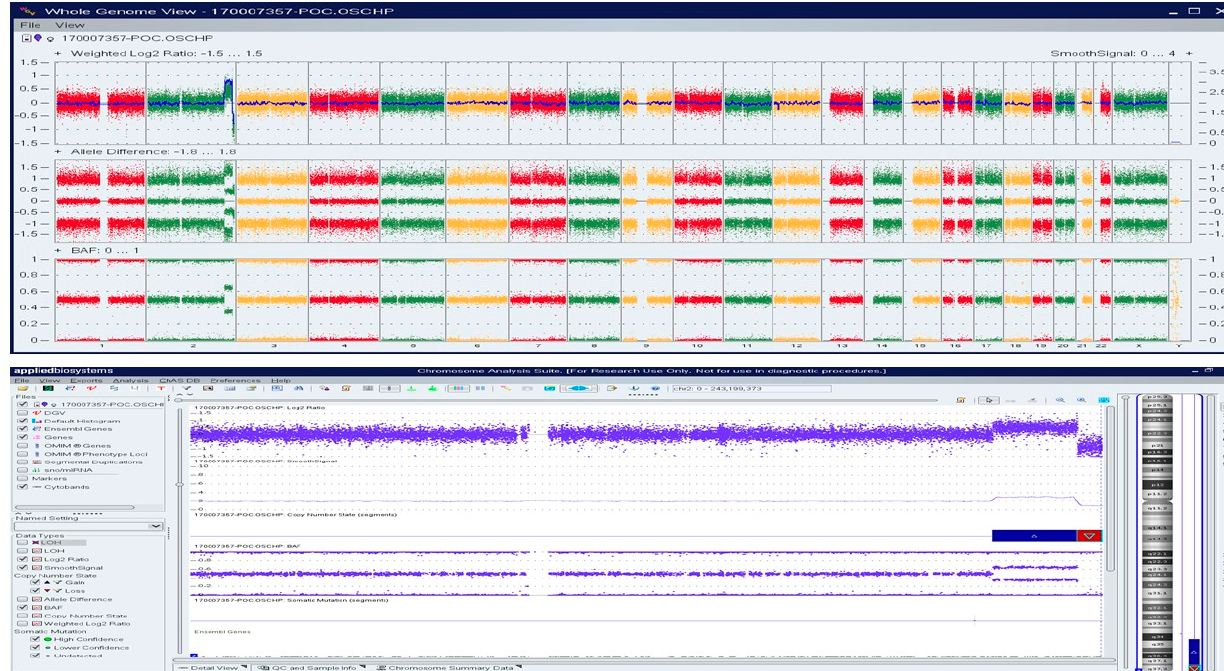
Figure 6. OncoScan analysis identified 22.6 Mb copy gain of Chr 2q34q37.2 and a 6.4 Mb copy loss of Chr 2q37.2q37.3, indicating a complex rearrangement involving the long arm of chromosome 2: Upper panel shows the whole-genome view.Lower panel shows the log2ratio, smooth signal, and BAF of chr 2.